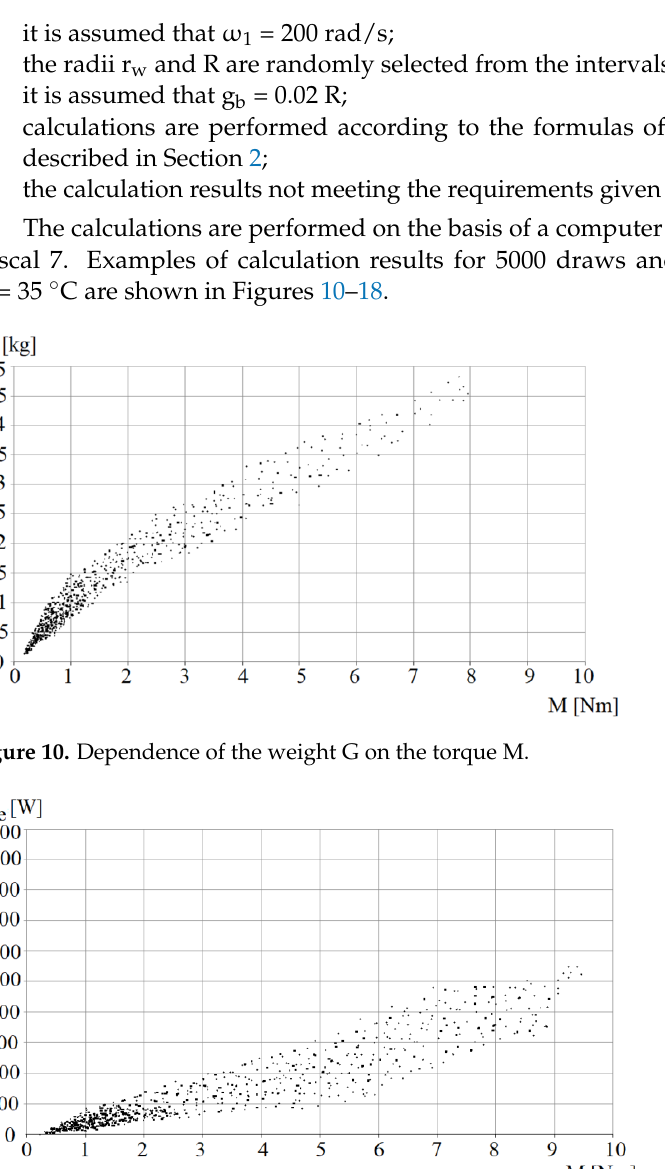
Figure 11. Dependence of the electric power P e on the torque M.